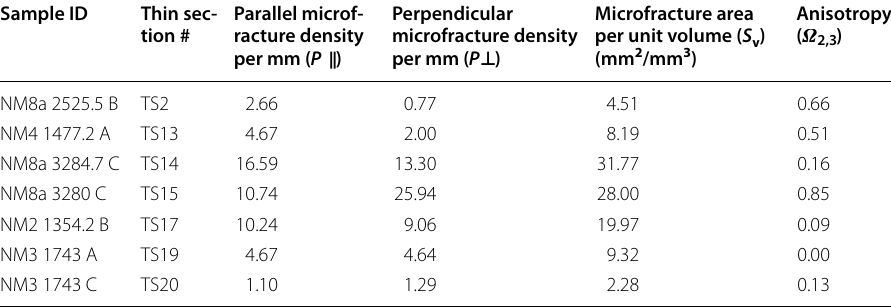
Table 3 Quantitative analysis of thin sections with